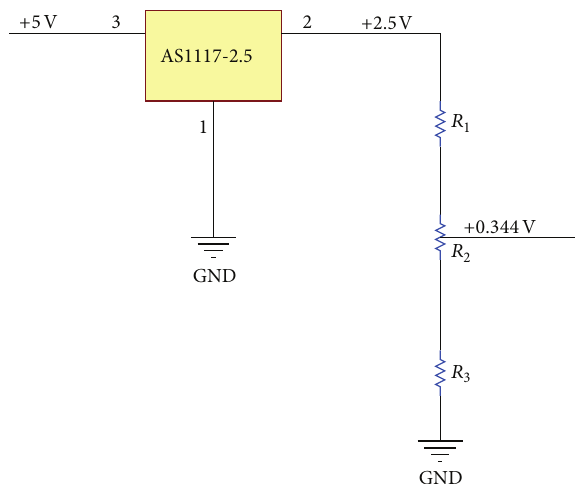
Figure 9: The circuit of offset voltage of the